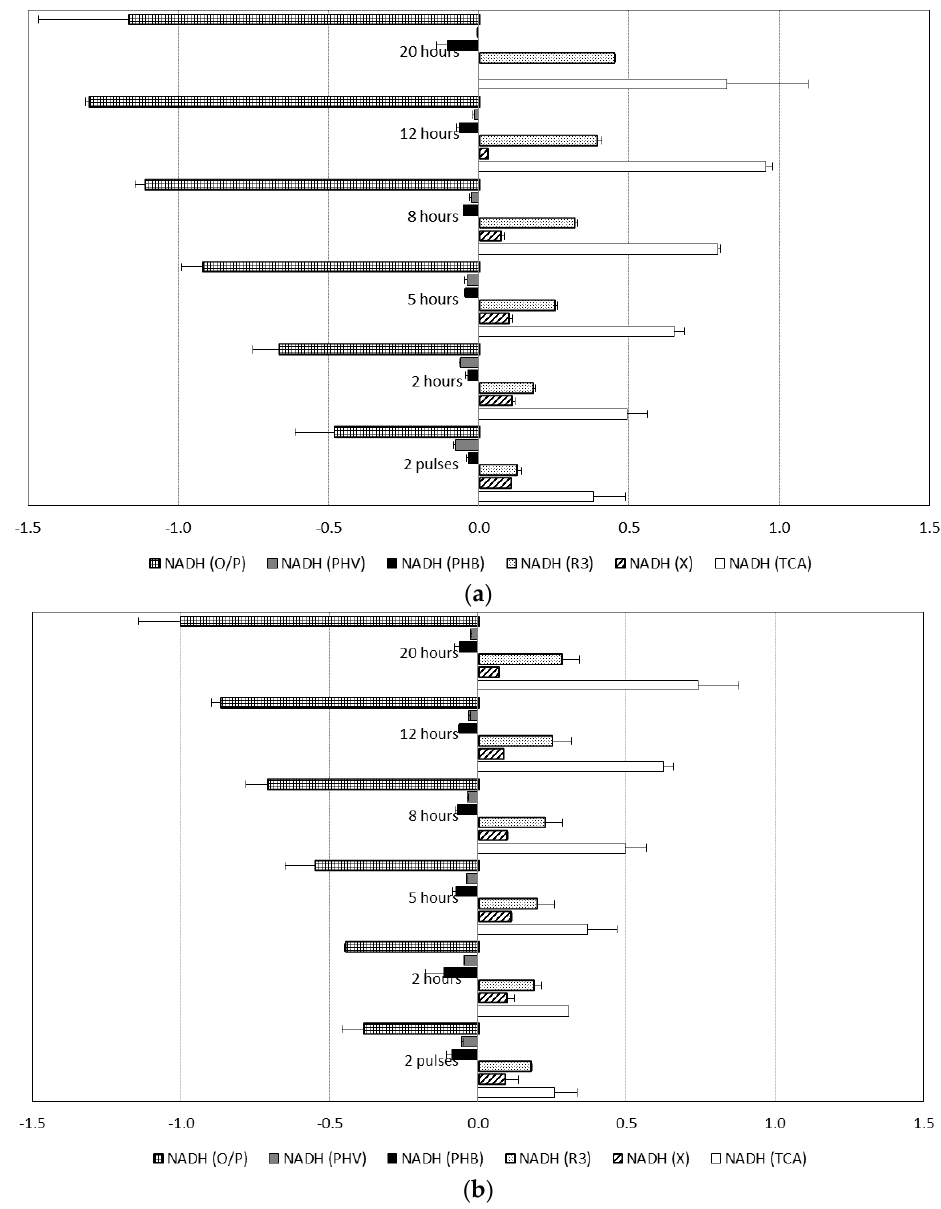
Figure 5. NADH generated and consumed at different stages of culture obtained by metabolic flux analysis (MFA): ( a ) Experiment set 3: 50% acetic acid and 50% propionic acid fed simultaneously; and ( b ) Experiment set 4: 100% acetic acid alternating with 100% propionic acid. (NADH was considered as internal metabolite).